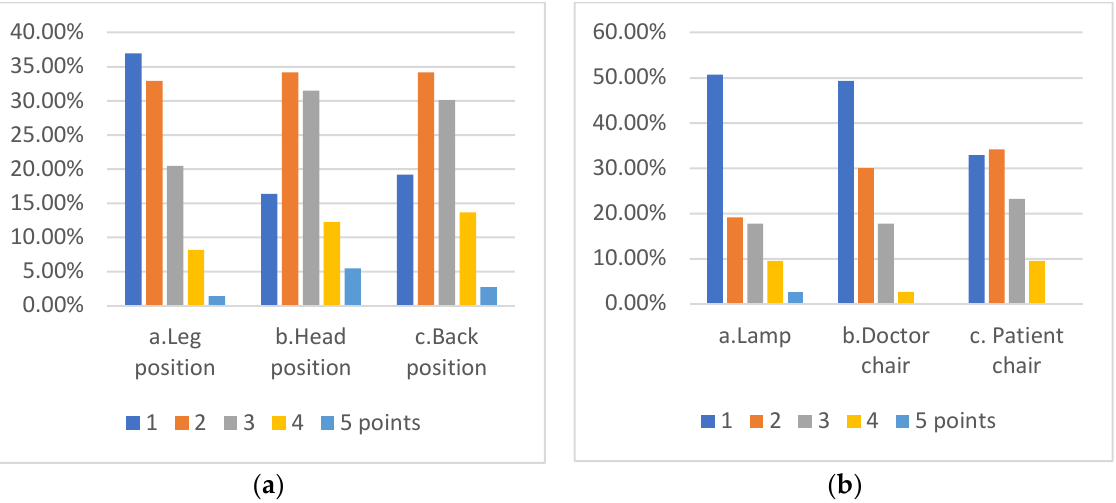
Figure 3. Clinician and dental equipment positioning in regard to the ISO 11226 in dental medicine. ( a ) Description of rating scores on parameters connected to the position of the doctor performing positions.